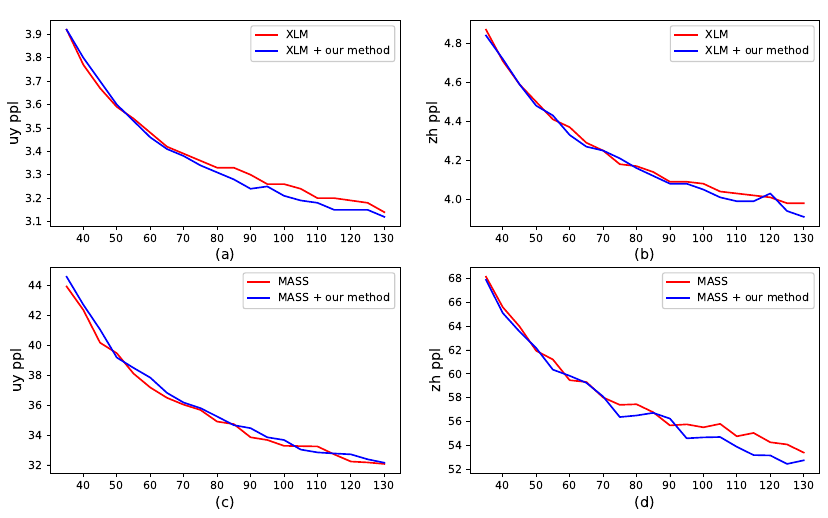
Figure 4. The perplexity (PPL) scores of different pre-training models on the validation set with respect to the epoch during pre-training. ( a ) the Uyghur results of XLM and our method based on XLM; ( b ) the Chinese results of XLM and our method based on XLM; ( c ) the Uyghur results of MASS and our method based on MASS; and ( d ) the Chinese results of MASS and our method based on MASS.